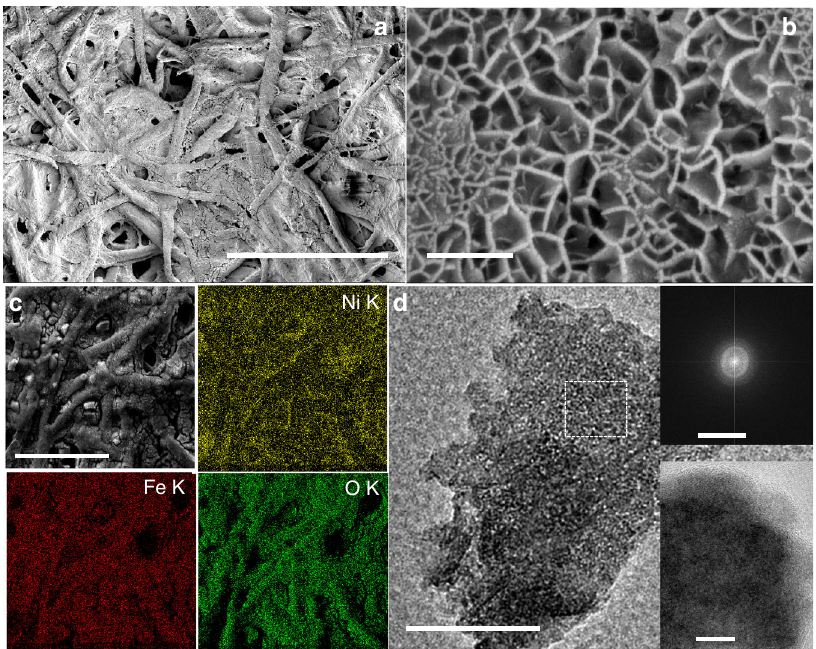
Fig. 2 High resolution FE-SEM and HR-TEM micrographs of NiFe/Ni-P electrode. a Low (scale bar 100 μ m) and b high resolution FE-SEM images of Ni x Fe 1- x OOH fi lm on Ni-P (NiFe/Ni-P) (scale bar 200 nm). c EDX elemental mapping of the NiFe/Ni-P electrode surface (scale bar 200 μ m). d TEM micrograph showing a rippled nanosheet like morphology (scale bar 100 nm). Insets show the SAED pattern obtained from the area marked in white (scale bar 10 nm − 1 ) and corresponding high resolution TEM image (scale bar 10 nm), both of which con fi rm the amorphous nature of